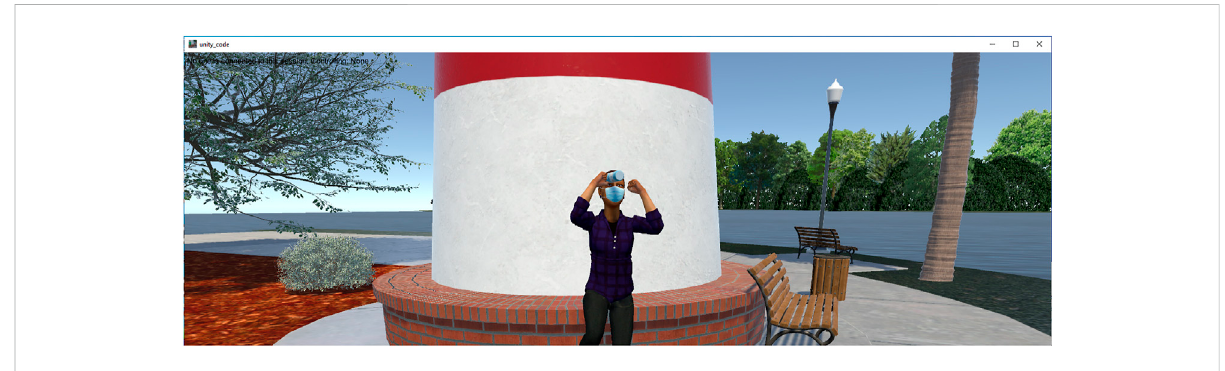
FIGURE 1 Stacy in the familiarization scenario at level 5, furious.